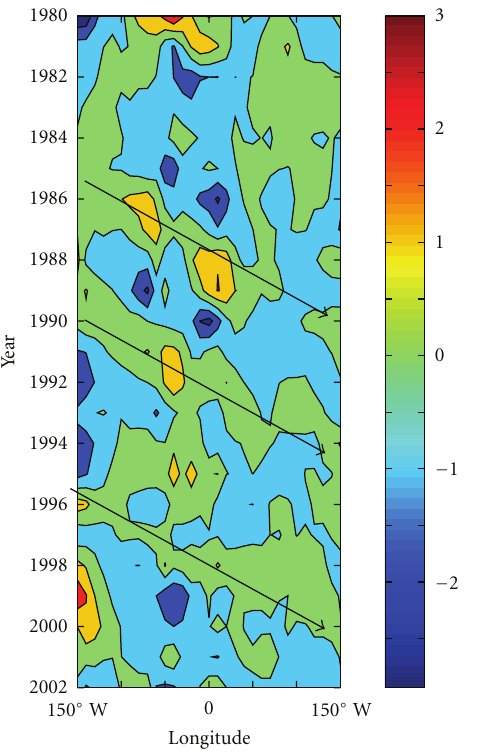
Figure 16: Time-longitude diagrams of inter-annual anomalies of the sea-ice extent during 1980 to 2002. Sea-ice extent data were averaged every 10 ◦ longitude. Arrows indicate the propagation of Antarctic Circumpolar Wave inferred from the inter-annual